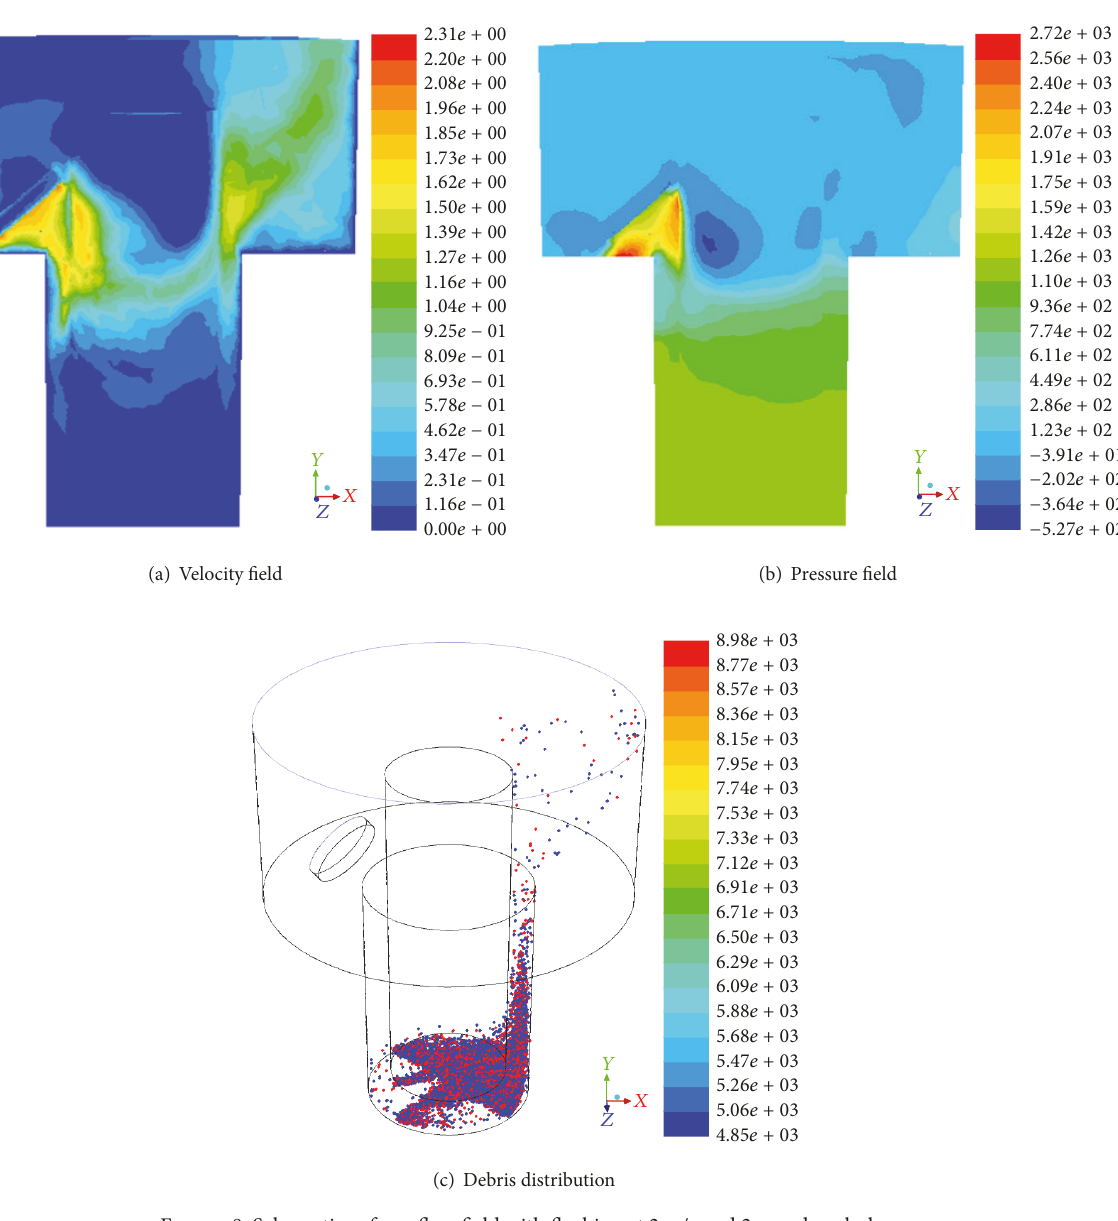
Figure 8: Schematics of gap flow field with flushing at 2 m/s and 2 mm deep